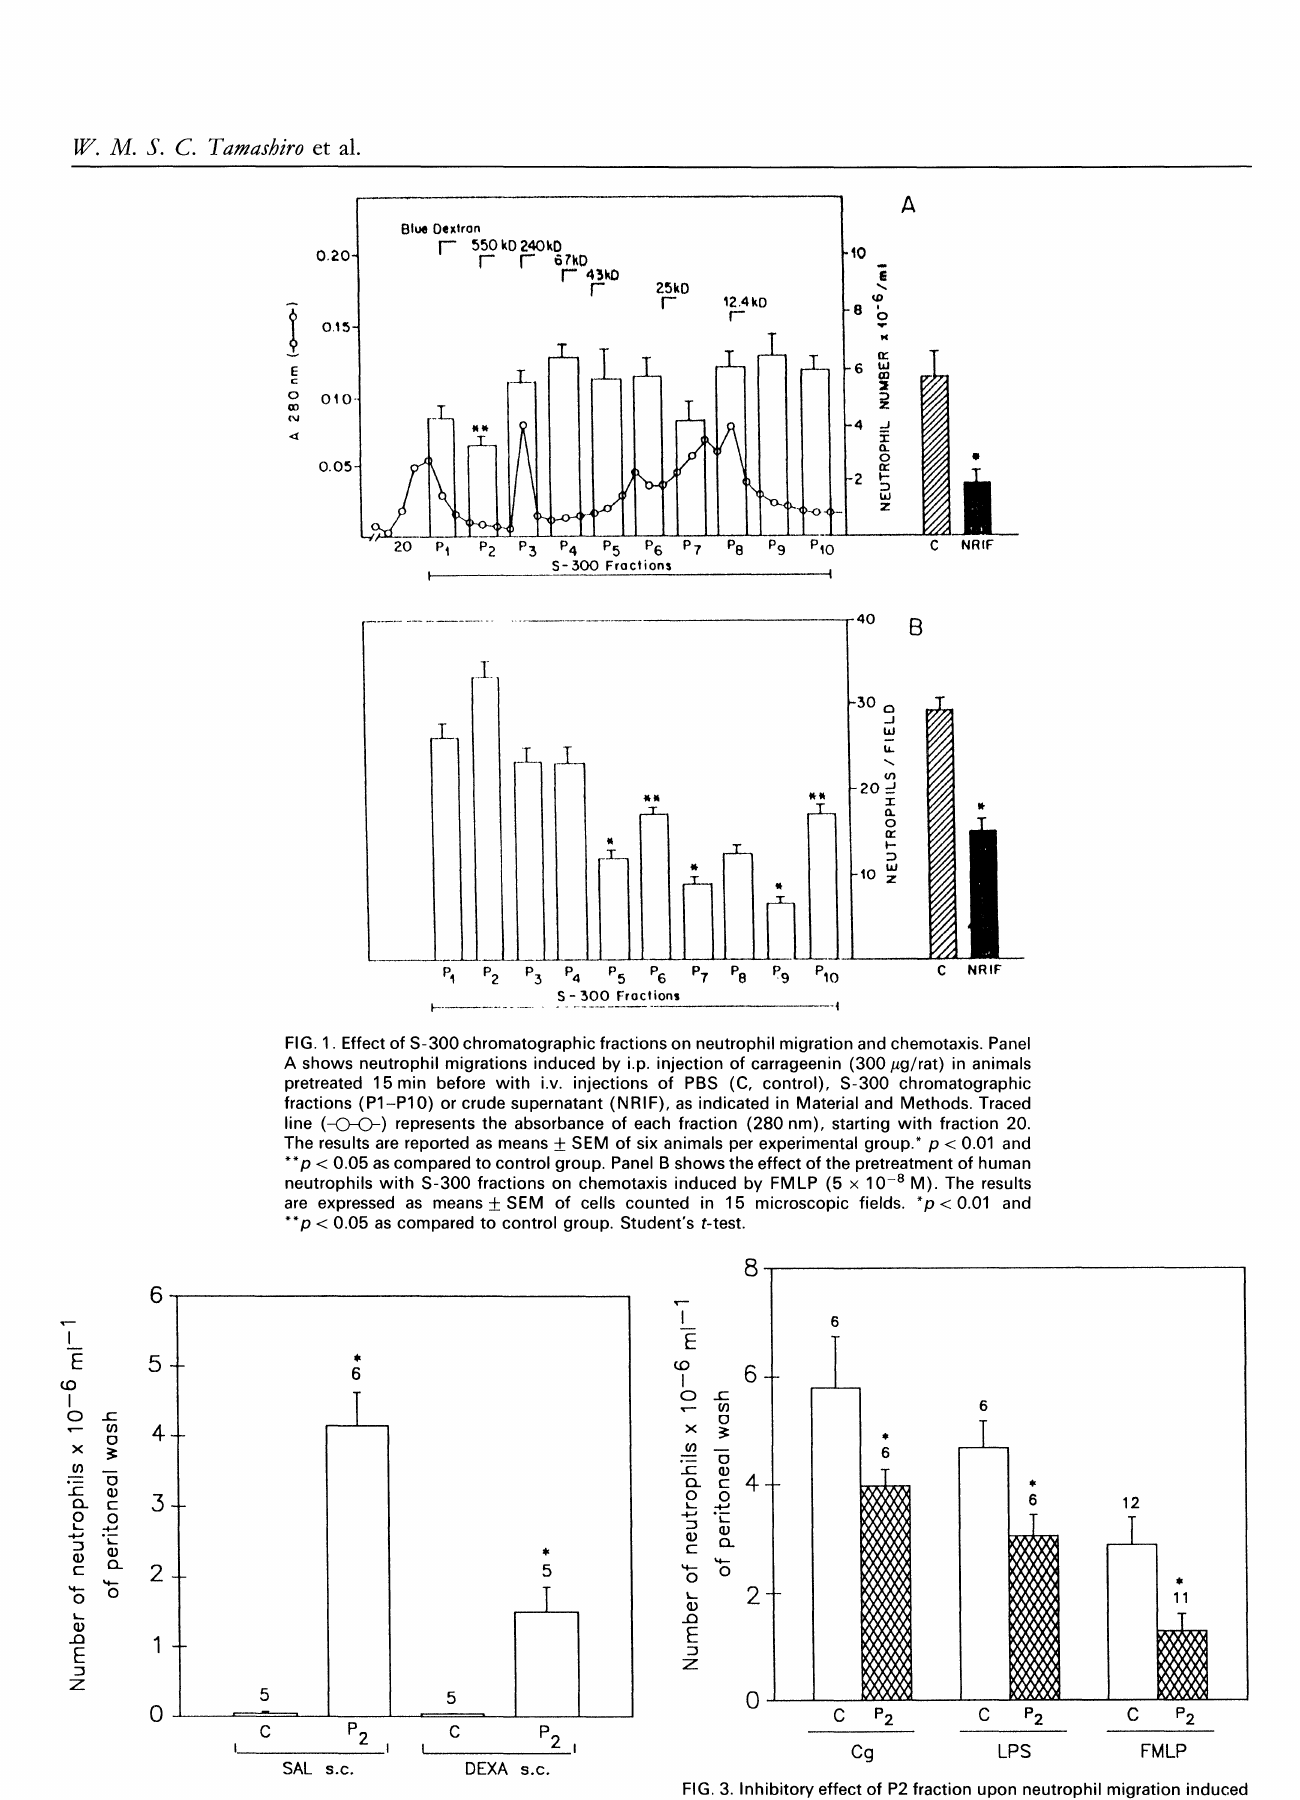
FIG. 1. Effect of S-300 chromatographic fractions on neutrophil migration and chemotaxis. Panel A shows neutrophil migrations induced by i.p. injection of carrageenin (300 #g/rat) in animals pretreated 15 min before with i.v. injections of PBS (C, control), S-300 chromatographic fractions (P1-P10) or crude supernatant (NRIF), as indicated in Material and Methods. Traced line (--O-O-) represents the absorbance of each fraction (280 nm), starting with fraction 20. The results are reported as means SEM of six animals per experimental group.* p < 0.01 and **p < 0.05 as compared to control group. Panel B shows the effect of the pretreatment of human neutrophils with S-300 fractions on chemotaxis induced by FMLP (5 x 10 -8 M). The results are expressed as means_+ SEM of cells counted in 15 microscopic fields. *p< 0.01 and **p < 0.05 as compared to control group. Student’s t-test.